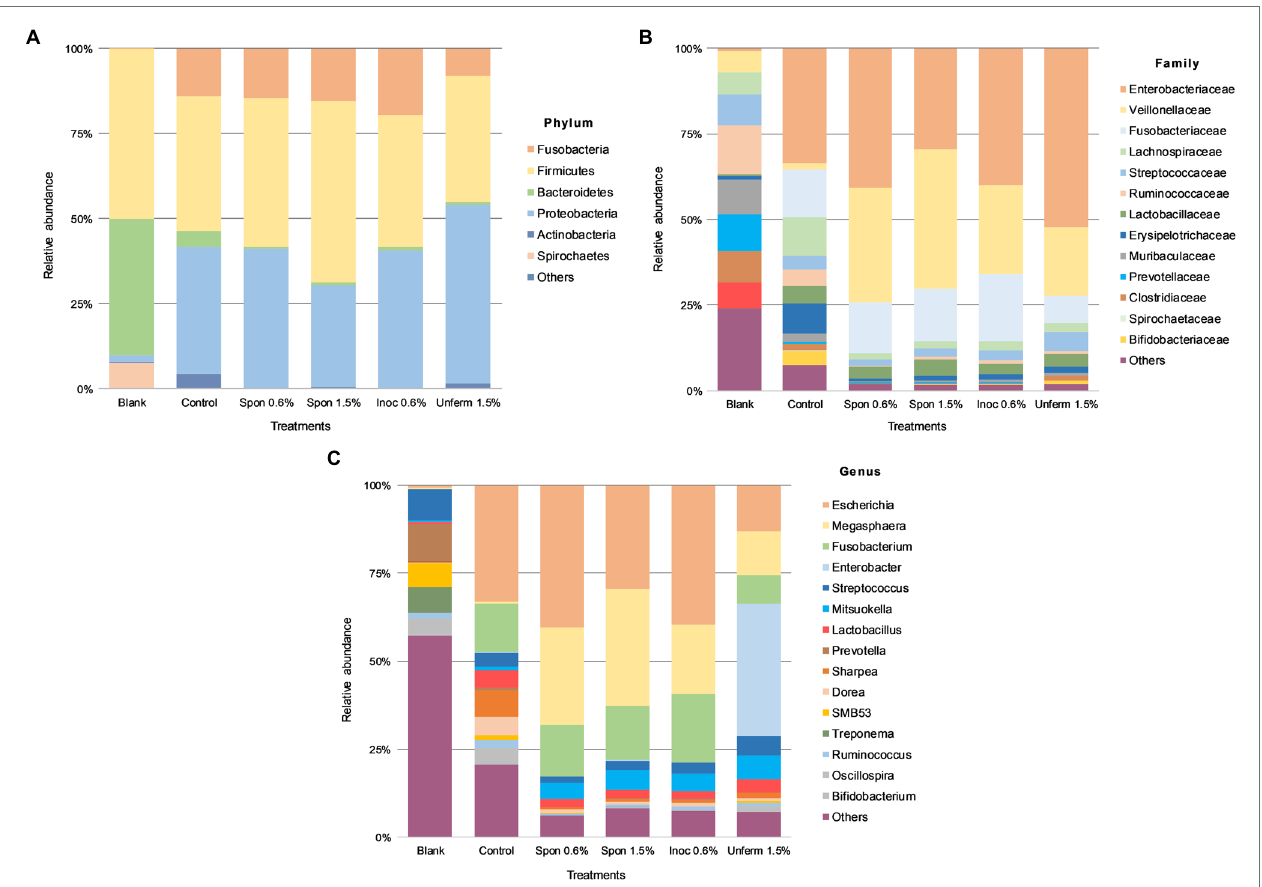
FIGURE 5 | Colonic fermentation of digested sauerkraut affects the final gut bacterial profile. Microbial taxa are characterized to the phylum (A) ; family (B) ; genus (C) levels. Dominant bacterial taxa are given with greater than 1.0% relative abundance. Blank: fecal slurry with digestive fluids. Control: fecal slurry with digestive fluids post-colonic fermentation. Spon 0.5%: spontaneously fermented sauerkraut with 0.6% salt; Spon 1.5%: spontaneously fermented sauerkraut with 1.5% salt; Inoc 0.6%: inoculated sauerkraut with 0.6% salt; Unferm 1.5%: unfermented cabbage with 1.5%